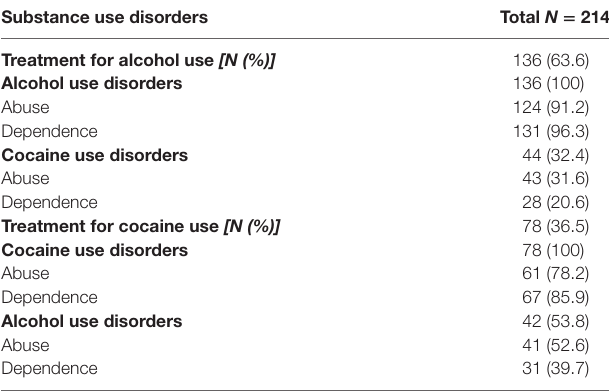
Table 2 | Prevalence of substance use disorders in patients treated for alcohol and cocaine.